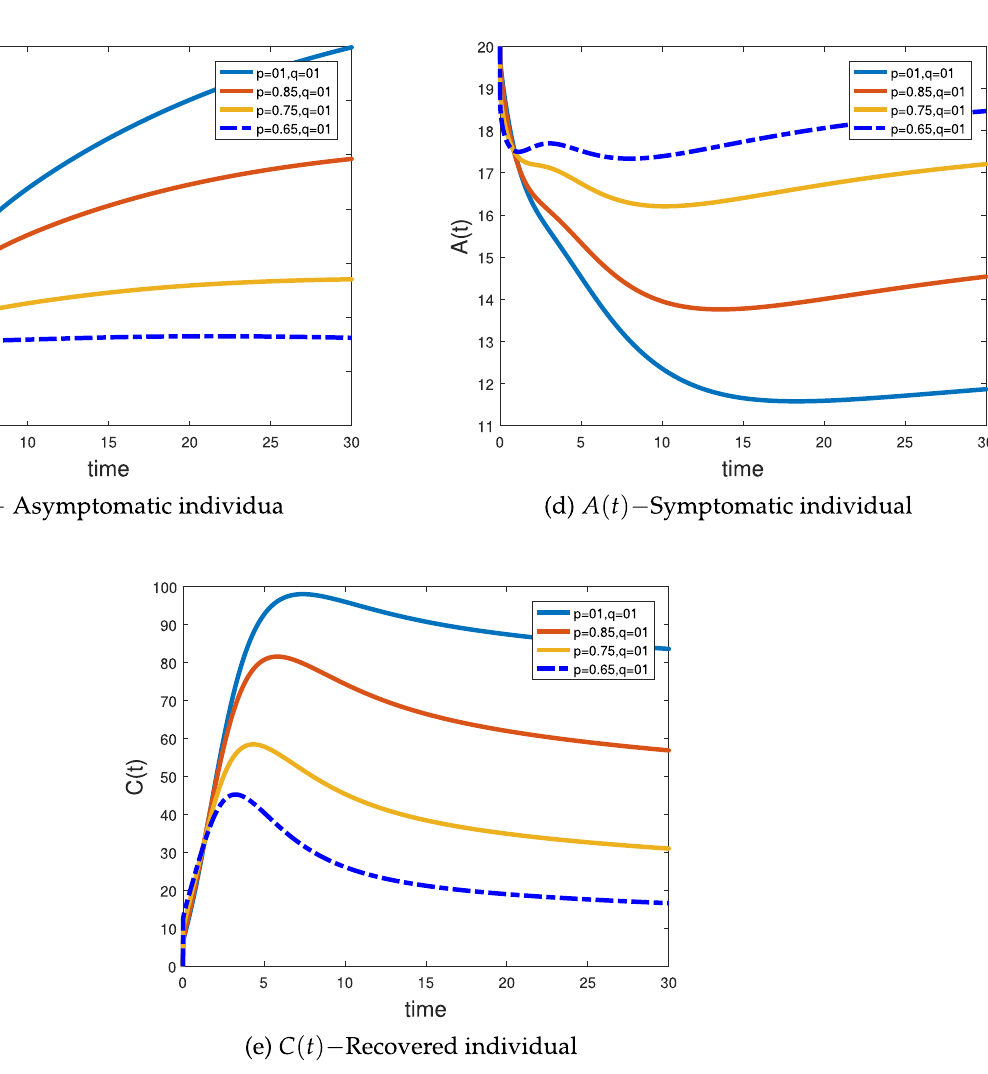
Figure 5. Simulations of the fractional-fractal NoV model in ABC case of system (36) when p = ( 01, 0.85, 0.75, 0.65 ) and q = ( 01, 01, 01, 01, 01 )